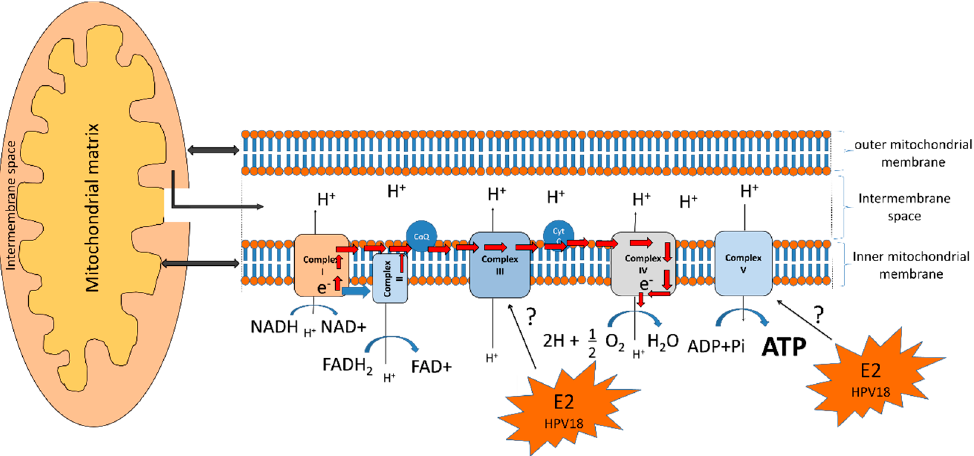
Figure 5. Modulation of the oxidative phosphorylation system by HPV18 E2 protein. Electrons are transferred from NADH or FADH 2 to O 2 using a series of electron carriers: Complex I, II, III, IV, and V favor the translocation of protons and generate an electrochemical gradient of protons in the intermembrane space. Red arrows show the electron flux. Electrons (e − ); protons (H + ); oxygen (O 2 ); water (H 2 O); coenzyme Q (CoQ), and cytochrome C (Cyt C). Since E2 modifies the mitochondrial cristae morphology, releasing ROS, it could possibly modulate Complex III, which is a mediator of mitochondrial ROS production; and it could also modulate Complex V, which is a regulator of the mitochondrial cristae structure. The question mark (?) indicates the possible effect of E2 on the complexes III and V.